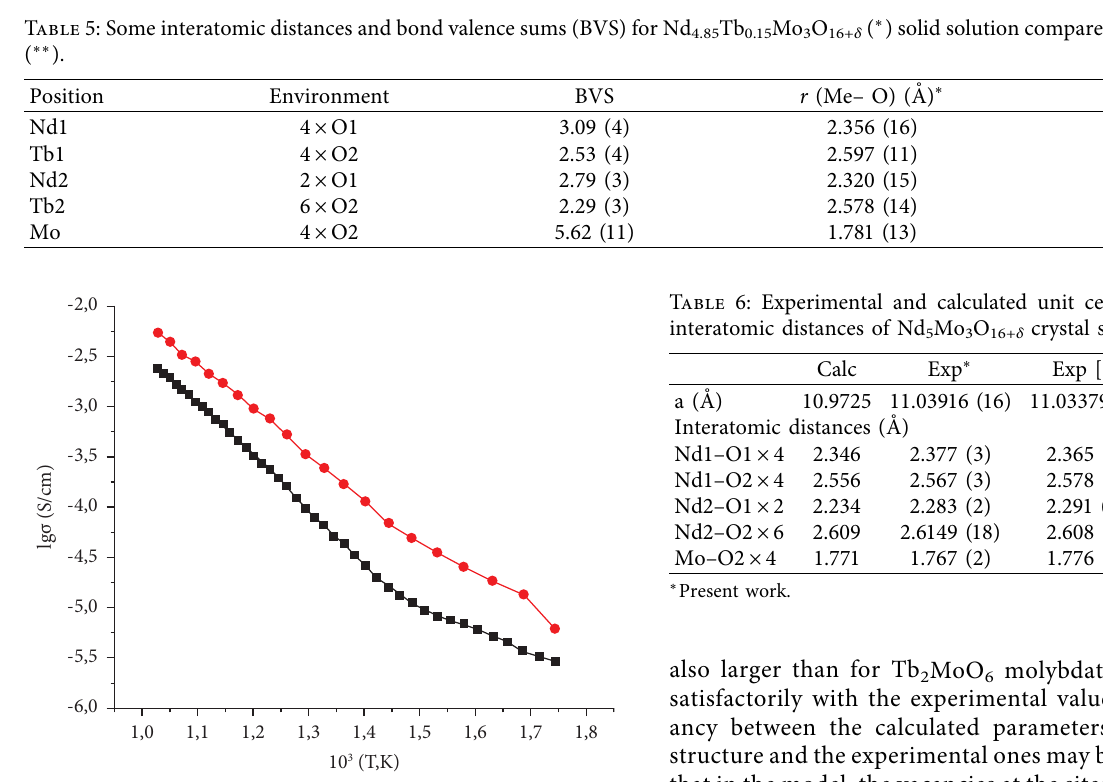
∗ ) solid solution compared to Nd 4.85 Tb 0.15 Mo 3 O 16+ δ (